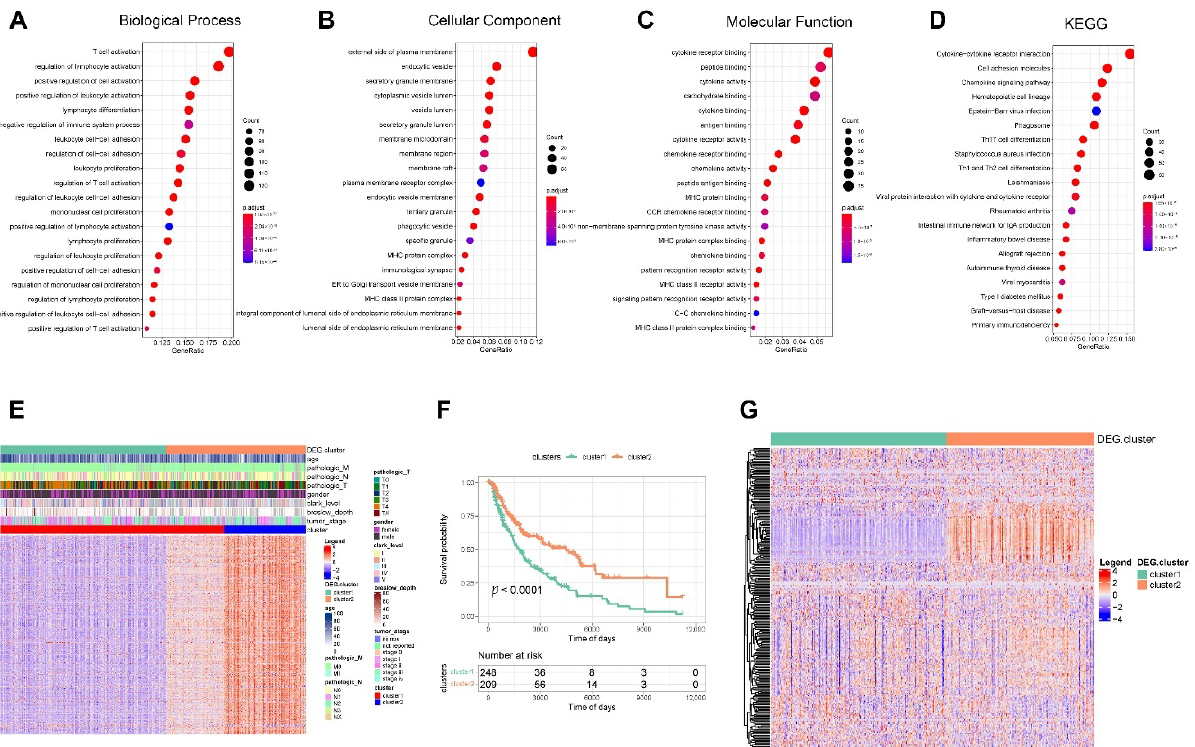
Figure 7. Validation of regulatory mechanisms among different phagocytosis subtypes. ( A – D ) Functional enrichment analysis of differentially expressed genes (DEGs). We screened for DEGs between subtypes based on protein-coding genes, obtained 661 DEGs based on thresholds, and then performed functional enrichment analysis on DEGs. ( A ) Functional analysis of biological process. ( B ) Functional analysis of cellular component. ( C ) Functional analysis of molecular function. ( D ) Functional analysis of KEGG. ( E , F ) Unsupervised clustering based on DEGs. ( E ) Expression heat map of DEGs. ( F ) Kaplan-Meier curves between differential genetic subtypes. Among them, cluster 1 contains 248 samples and cluster 2 contains 209 samples. ( G ) Heat map of the expression of phagocytosis regulators among differential genetic subtypes. Our results showed significant differences in the expression of many phagocytosis regulators between subtypes.